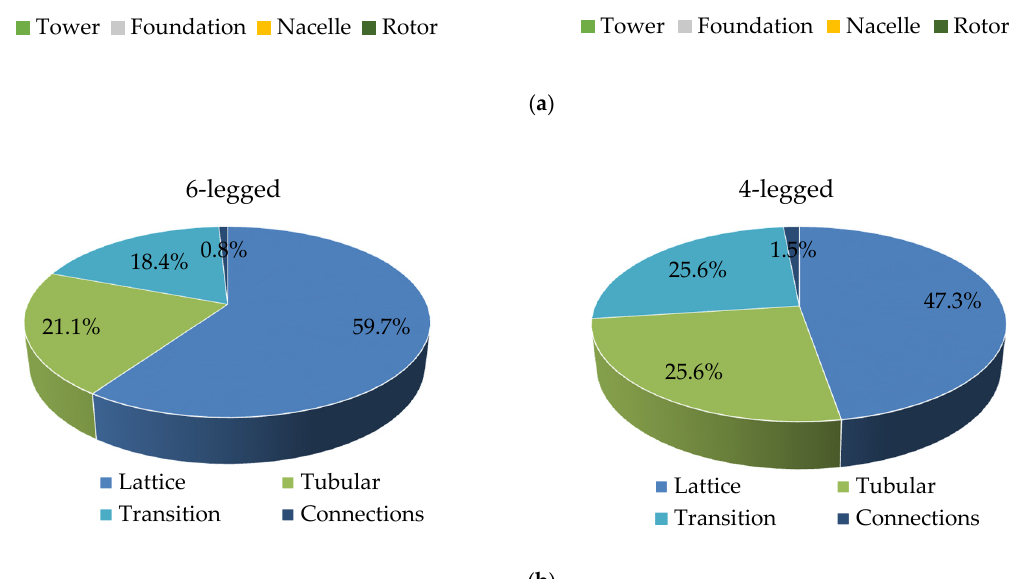
Figure 5. Mass distribution of the towers studied. ( a ) mass distribution, ( b ) tower mass distribution.